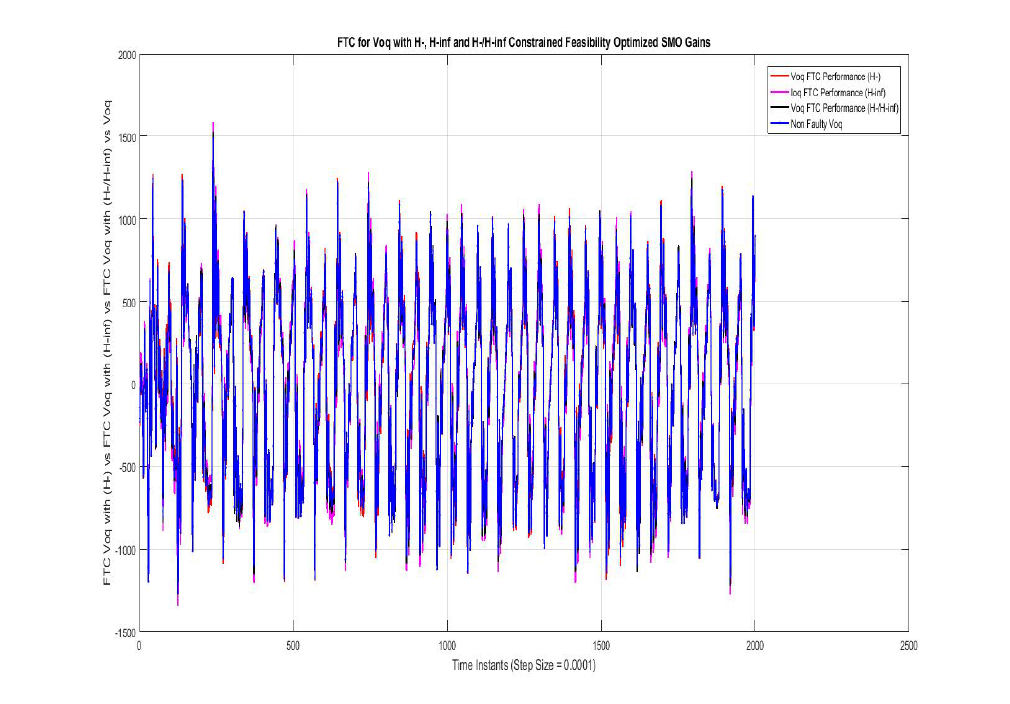
Figure 11. FTC for Ioq compared with feasibility optimized H − and H − / H ∞ SMO gains.